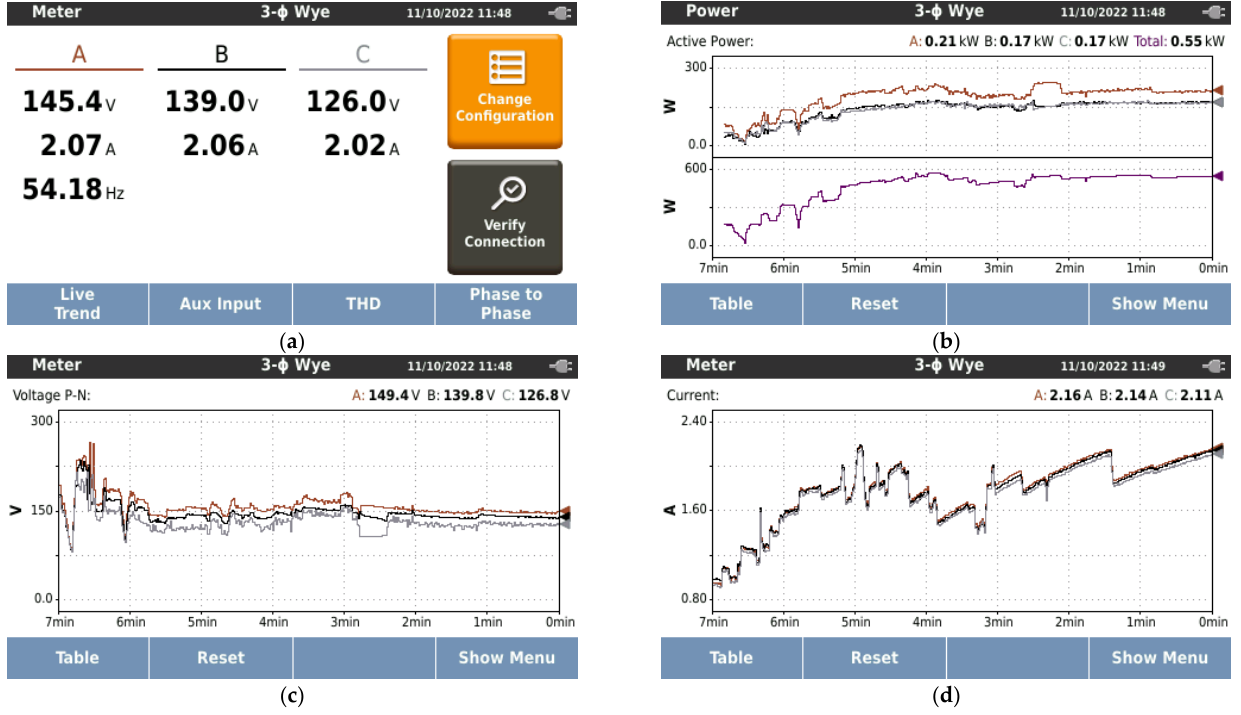
Figure 18. Speed variation effect on ( a ) power, ( b ) current, ( c ) power factor, and ( d ) voltage using the main voltage source.